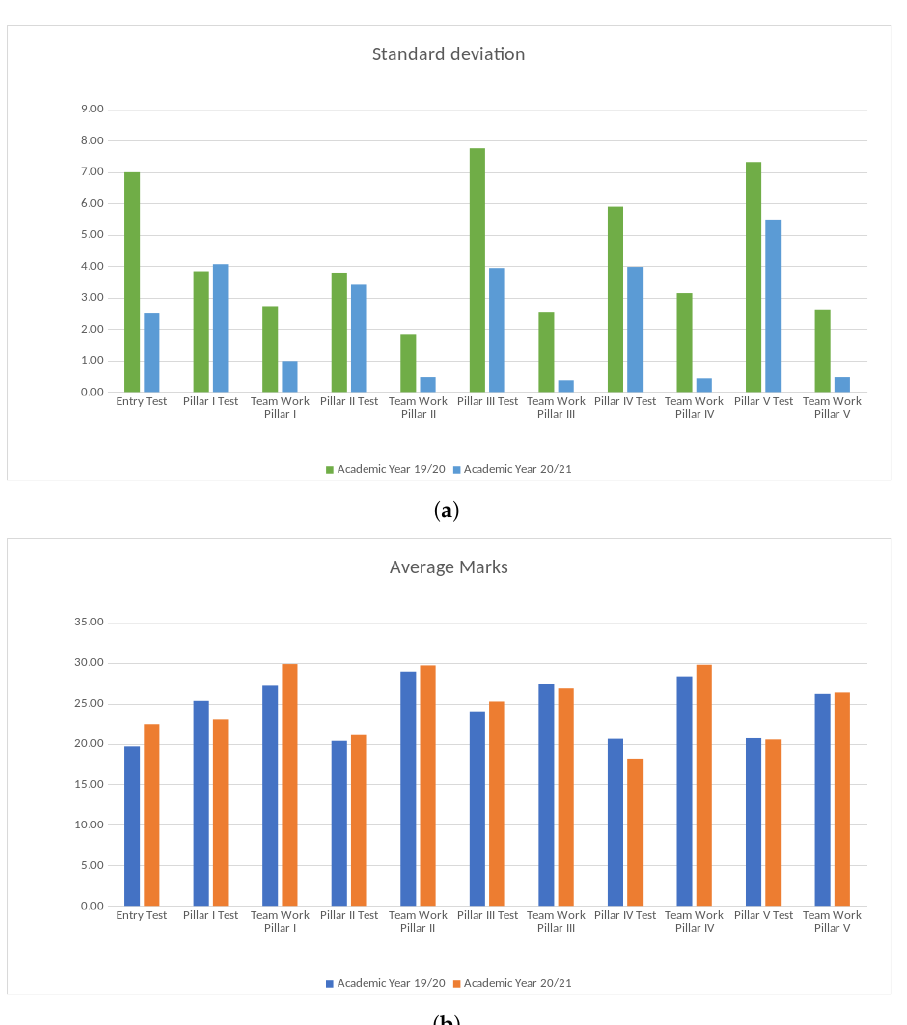
Figure 3. The comparison between the average and the standard deviation of the pillars. ( a ) The trend of the standard deviation. ( b ) The average marks for the